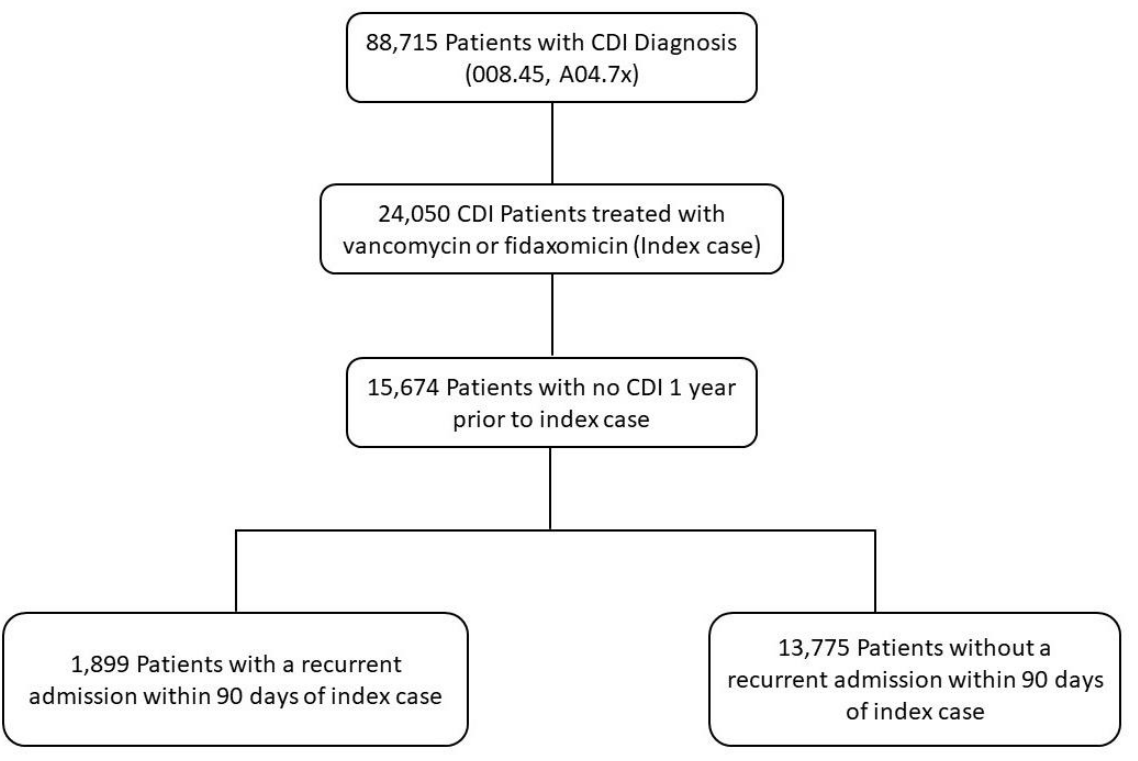
Figure 2. Data extraction diagram.